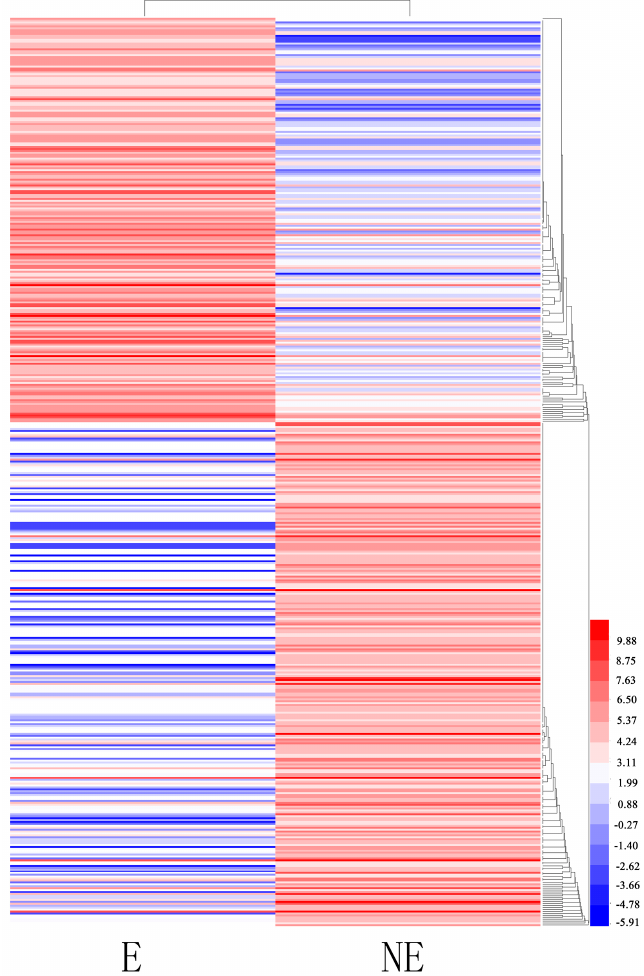
Figure 6. Clustering analysis of the total differentially expressed genes (DEGs) in etiolated (E) and control (non-etioleted, NE) plants based on their expression profiles obtained from RNA-sequencing (RNA-Seq) experiments. Color scale corresponds to the log2 (reads per kilobase of transcript per million mapped reads, RPKM) of different genes in the samples.